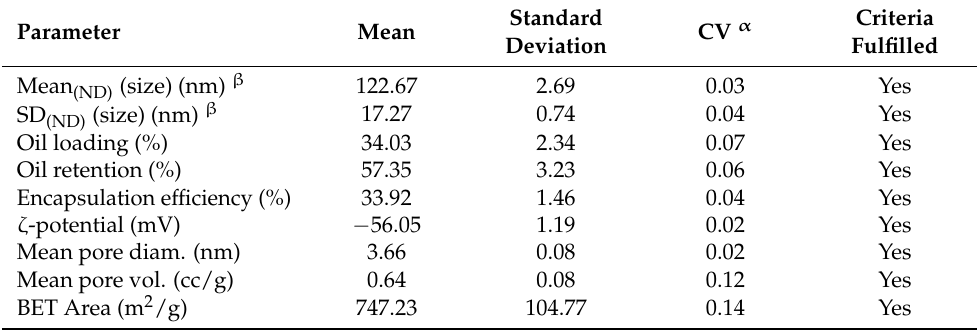
Table 1. Reproducibility analysis for synthesis of L-NPs (or E-NPs, given the case).